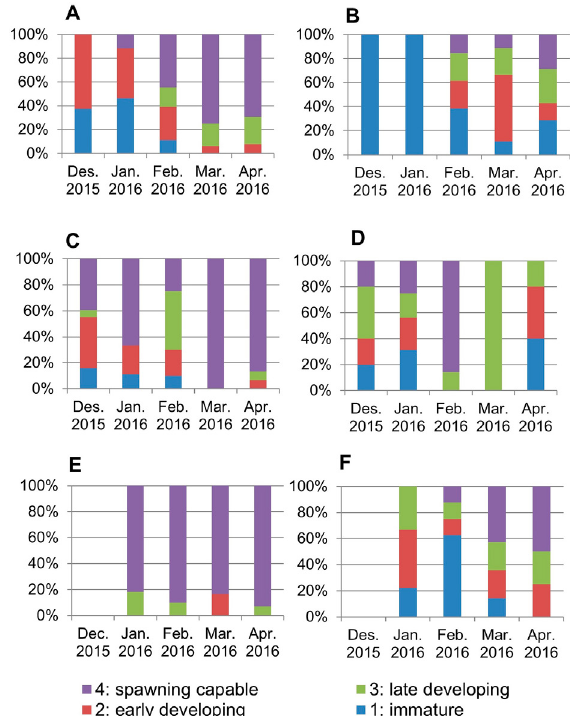
Fig. 4. – Monthly evolution of gonad stages of Aphia minuta (A, female; B, male), Pseudaphia ferreri (C, female; D, male) and Crystallogobius linearis (E, female; F, male), during the 2015-2016 fishing